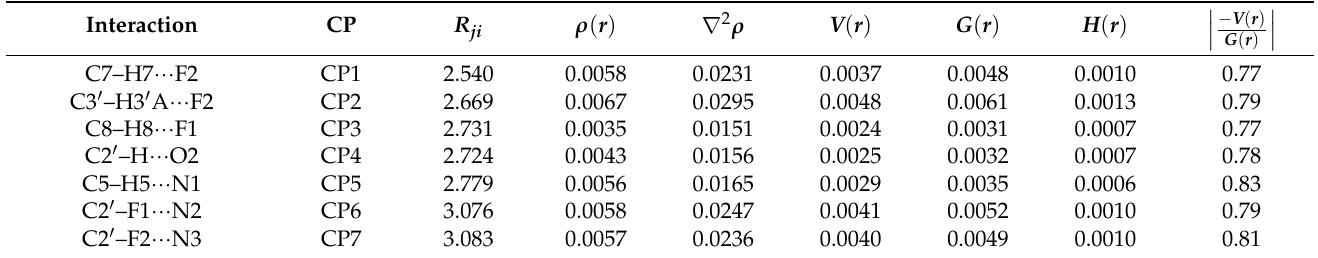
− 3 ); ∇ 2 ρ (r), Laplacian of electron density (e Å − 5 );